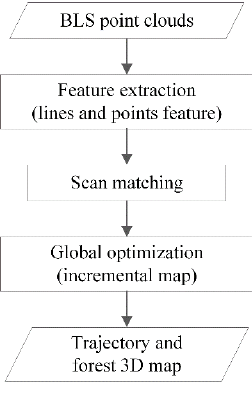
Figure 1. The flowchart